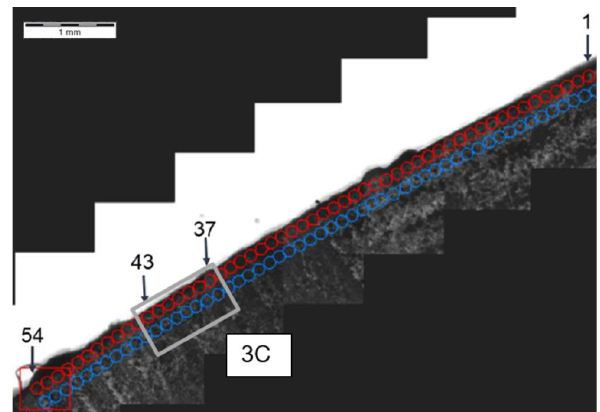
Figure 12. Localization of cross-section G-G, zone: 3C.